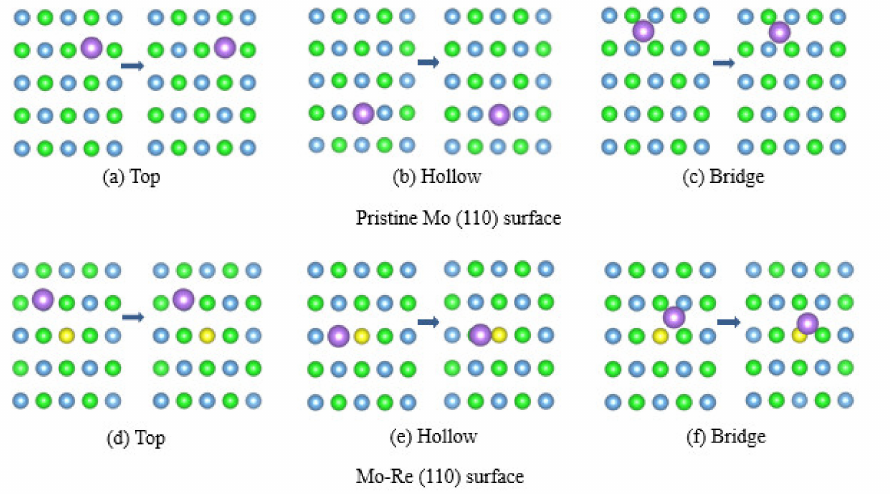
Figure 2. Initial and final configurations of Na adsorption on Mo (110) and Mo-Re (110) surfaces. Snaps ( a – c ) show Na atoms initially placed at Top site, Hollow site and Bridge site of Mo (110) surface. Snaps ( d – f ) show Na atoms initially placed at Top site, Hollow site and Bridge site of Mo-Re (110) surface. Blue and green spheres represent Mo atoms in the first layer and the second layer. Yellow and purple spheres represent Re atoms and Na atoms,